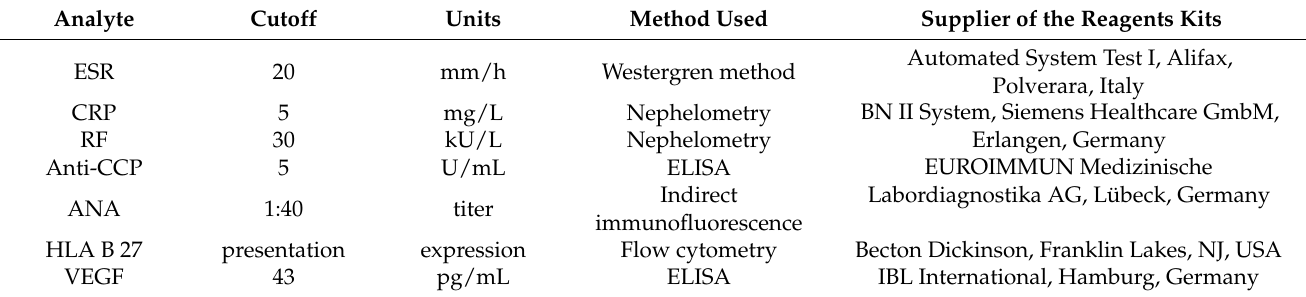
Table 1. Description of laboratory tests.